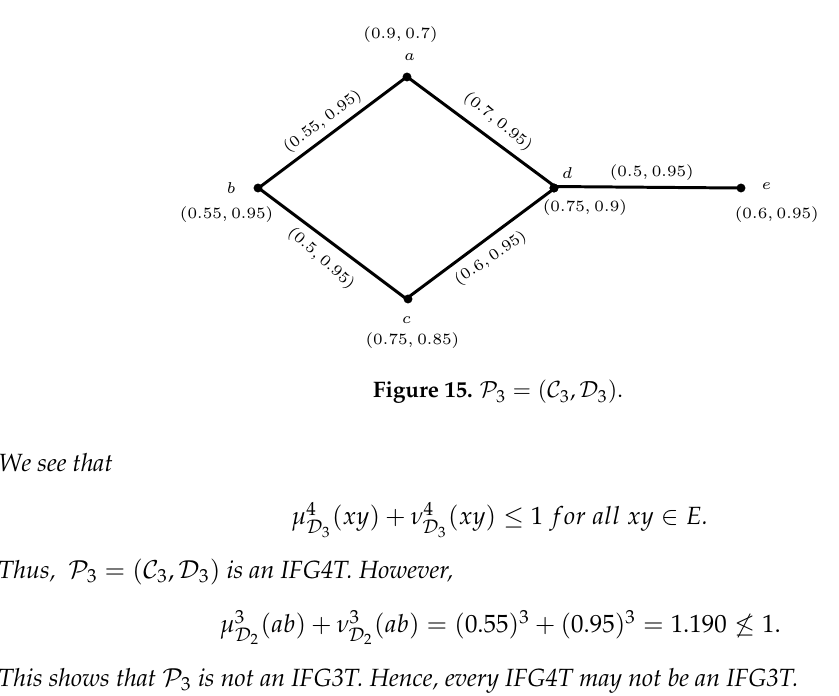
Figure 15. Figure 3.5: P Figure 3.5: P 3 = ( C 3 , D 3 )